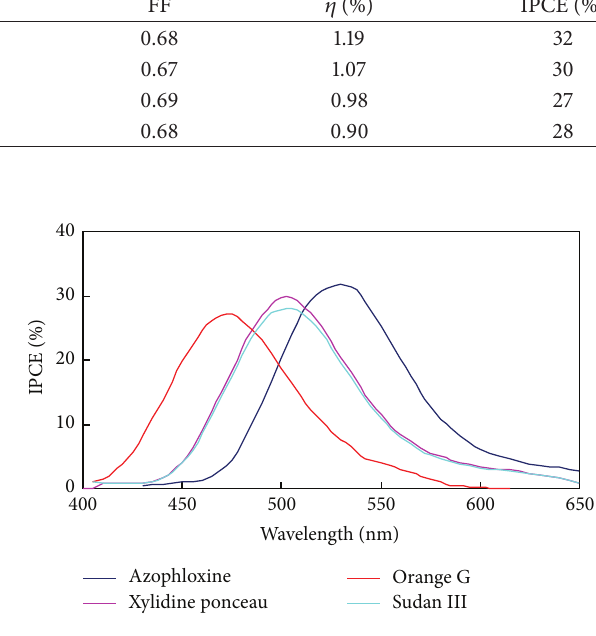
Figure 9: The action spectra (IPCE- 𝜆 ) of nanocrystalline TiO 2 thin film electrodes sensitized by azo based